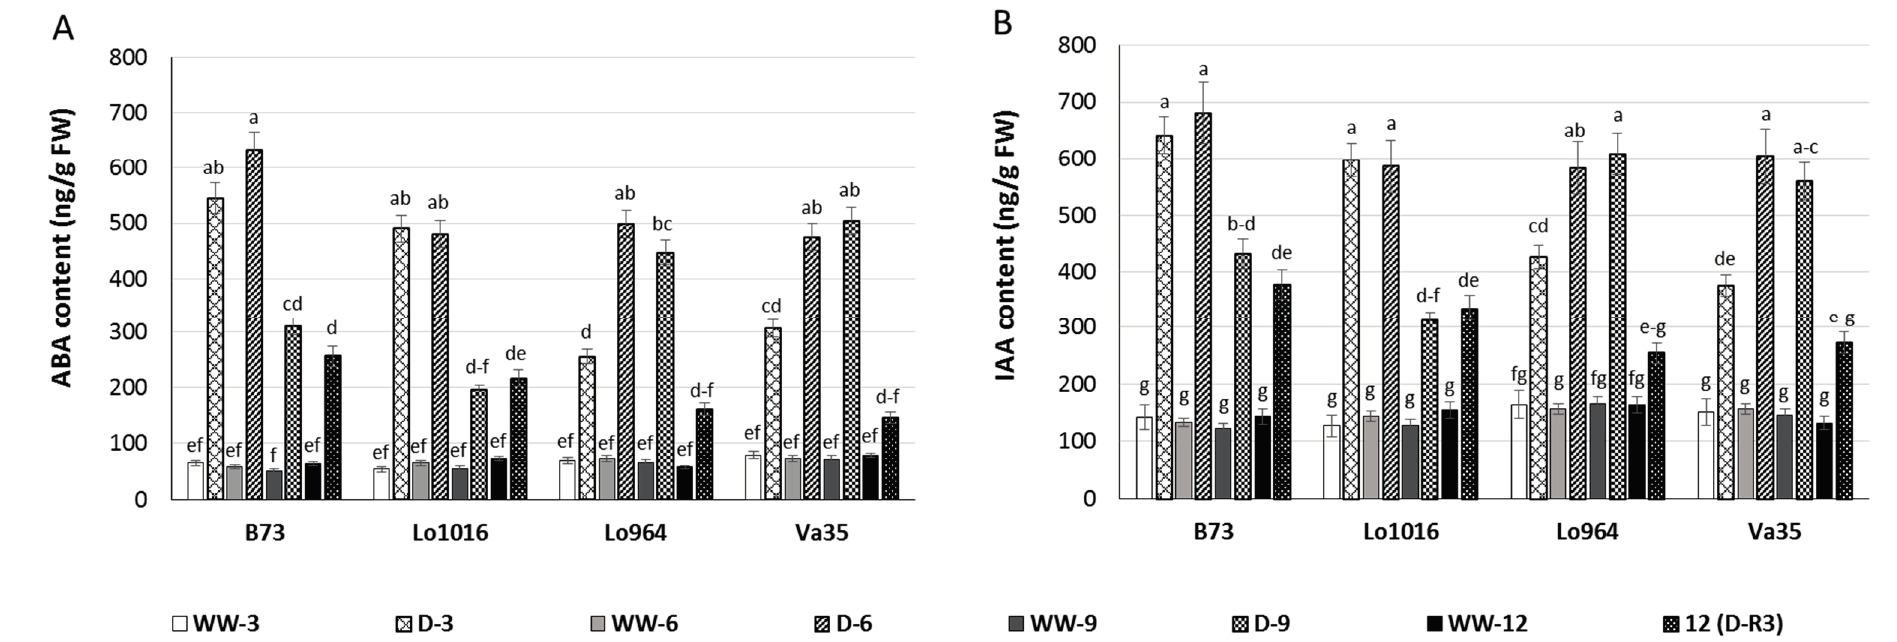
Figure 2. ABA and IAA content in maize seedling leaves under well-watered (WW) and drought (D) conditions. Phytohormone levels were measured in sensitive and tolerant genotypes over drought stress and recovery including ABA ( A ); and IAA ( B ). Different letters indicate significant differences ( p < 0.05) based on Tukey’s test between control and treatments and between different treatment times. Data represent the mean ± SD of three or more